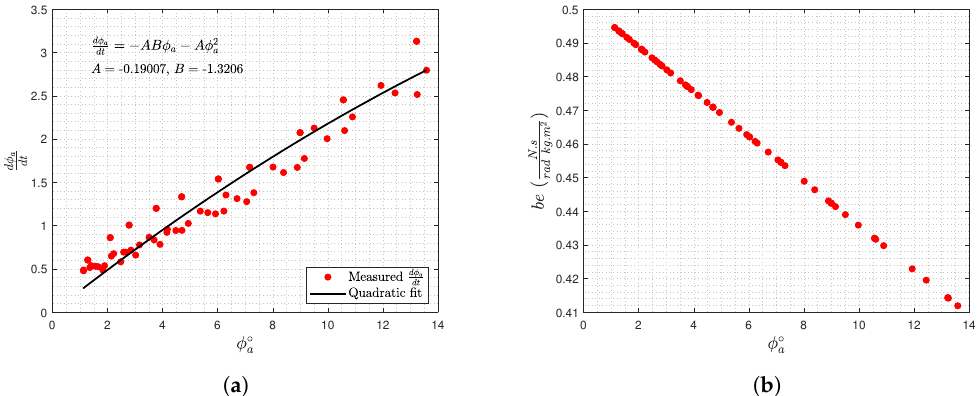
Figure 6. Equivalent linear damping coefficient estimation using Averaging method, test case 8 by combining results of 4 tests with different initial roll angles, see Section 3.3. ( a ) Estimation of A, B coefficients using quadratic curve fitting between d φ a and φ a Equation (27); ( b ) Equivalent linear dt damping coefficient be estimation based on b 1 and b 2 using Equations